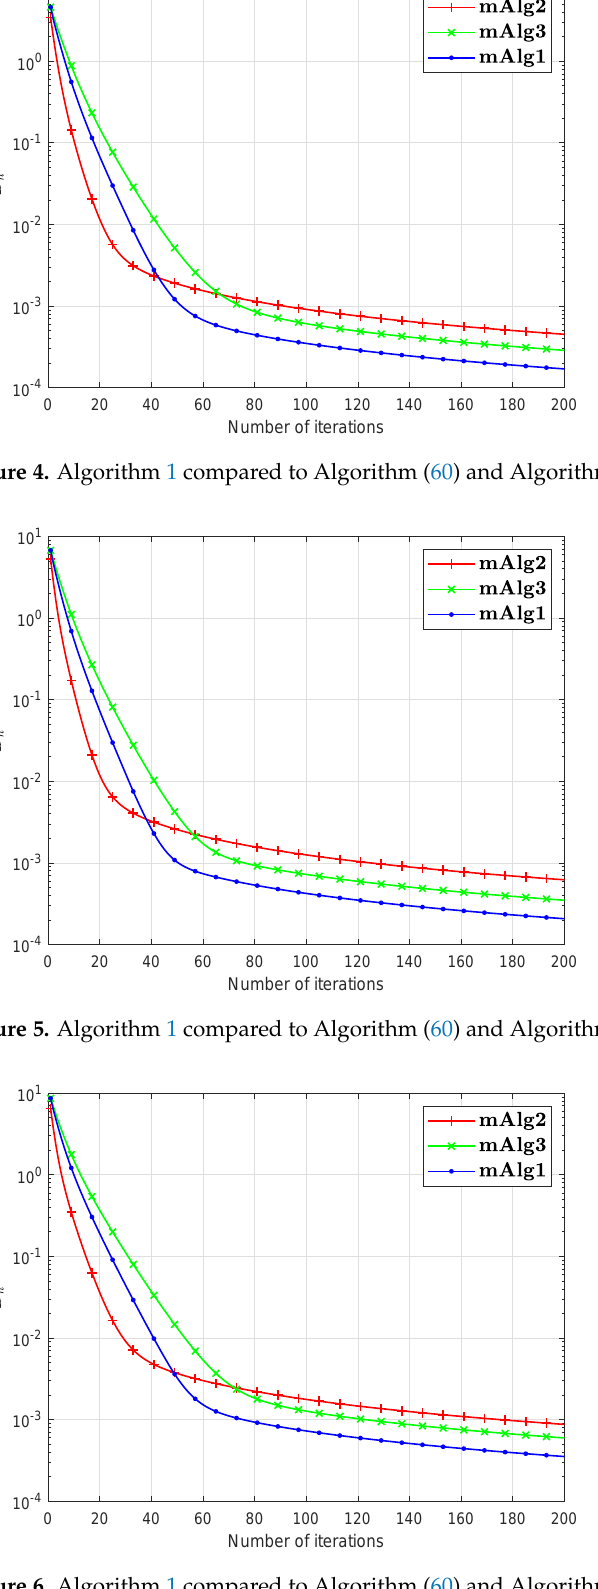
Figure 6. Algorithm 1 compared to Algorithm (60) and Algorithm 3.2 in [34] for R 200